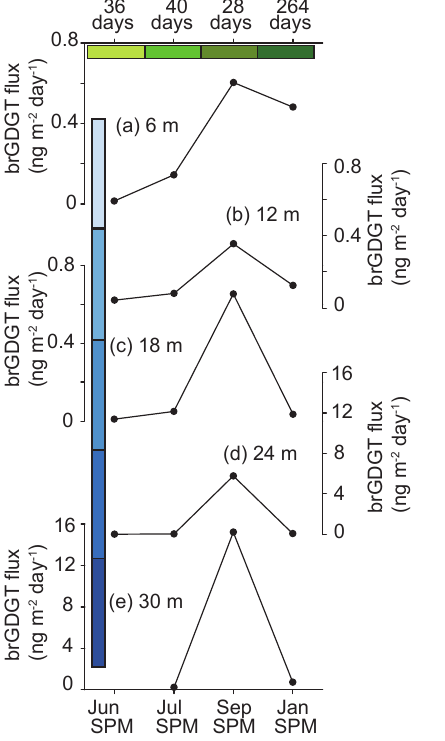
Figure 3. Time series of brGDGT fluxes for each of the sediment traps in Basin Pond. The brGDGT fluxes at 6 (a) , 12 (b) , 18 (c) , 24 (d) , and 30m (e) are shown. There are no data for the trap (e) in July 2014. Note the change of scale for (d) and (e) , indicating fluxes an order of magnitude higher for the lowermost traps. Green bars correspond to the time periods in Fig. 2. Blue bars correspond to the depth ranges in Fig. 5.